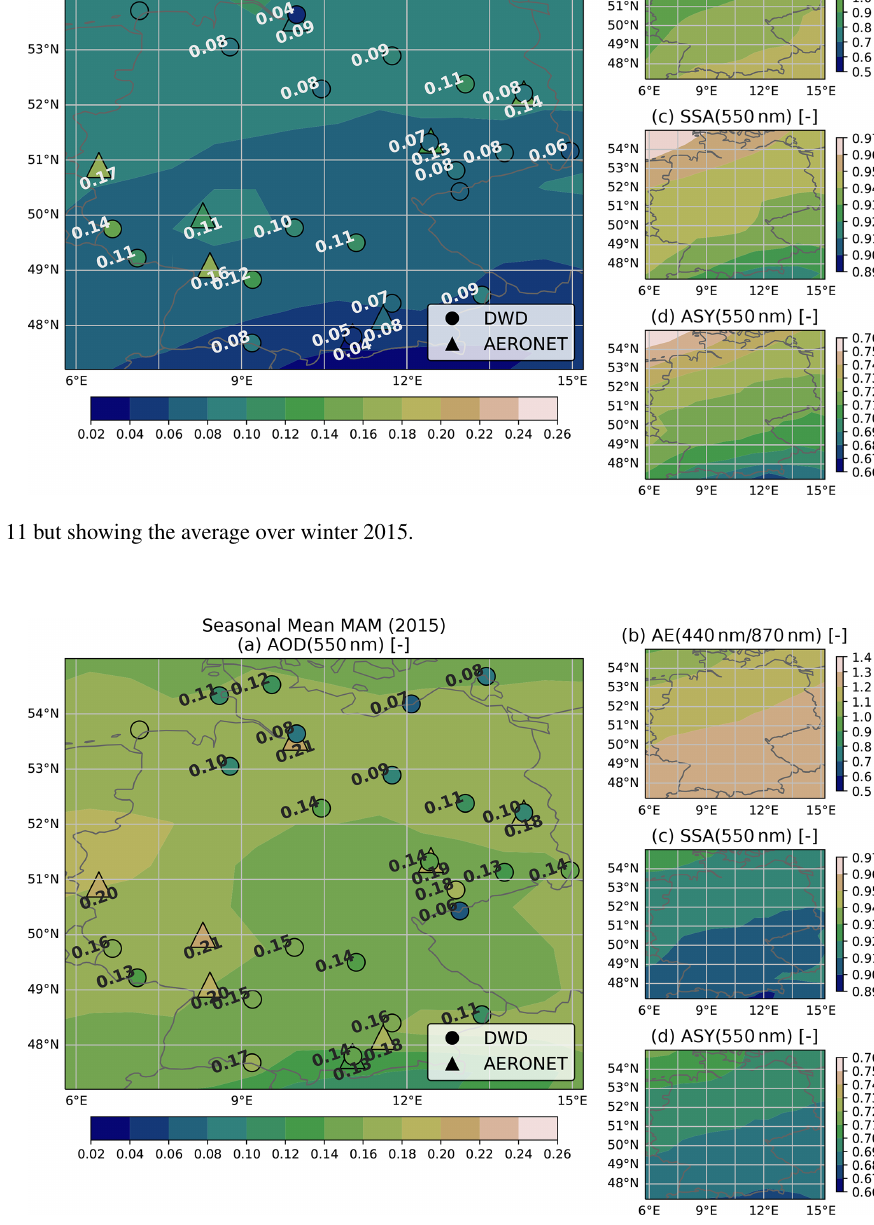
Figure D5. As Fig. 11 but showing the average over spring